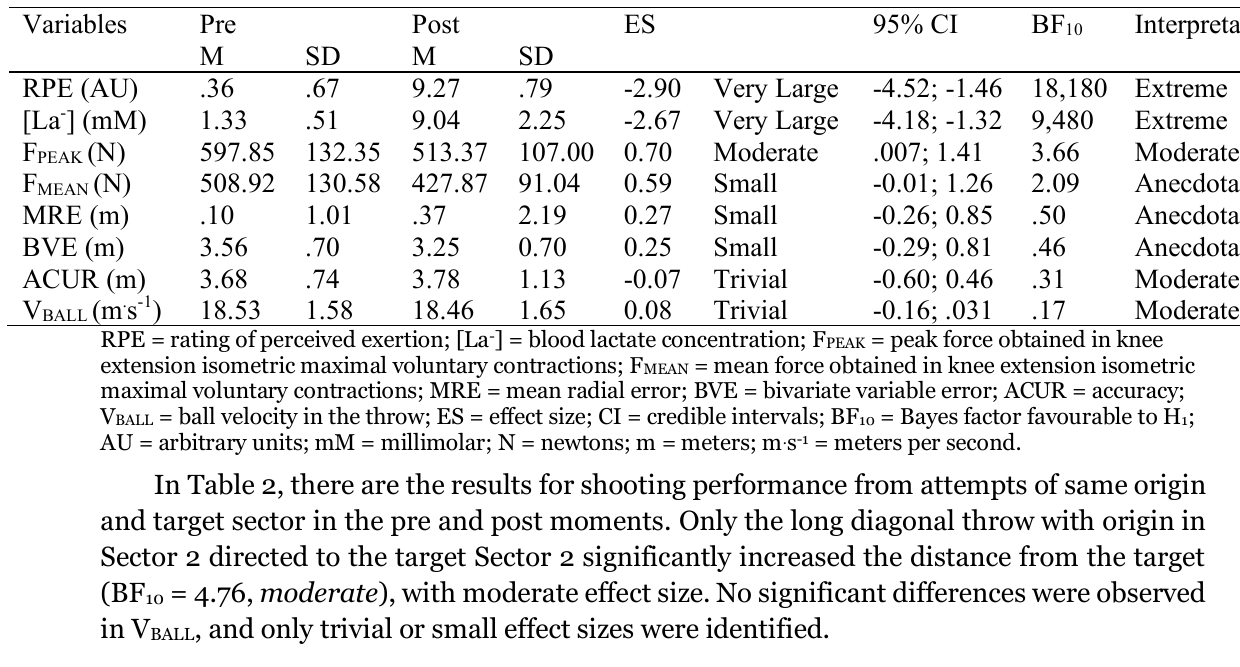
Table 1. Mean and standard deviation (standardized ES with a 95% confidence interval) for fatigability (n = 11) and overall shooting performance variables (n =